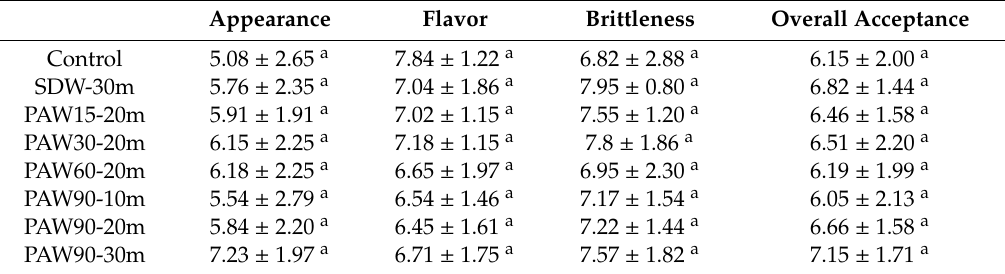
Table 3. Influence of plasma-activated water treatment on the sensory characteristics of thin sheets of bean